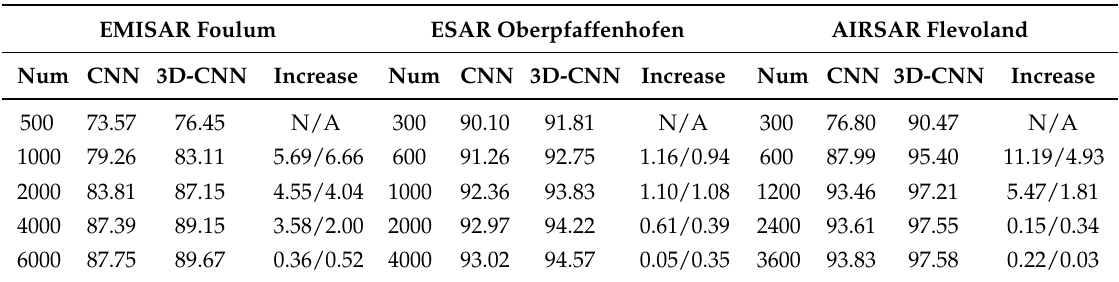
Figure 11. The influence of epoch on the performance of 3D-CNN. ( a ) The results on the AIRSAR Flevoland dataset. ( b ) The results on the EMISAR Foulum dataset. Table 4. Overall accuracy (%) under different sized training